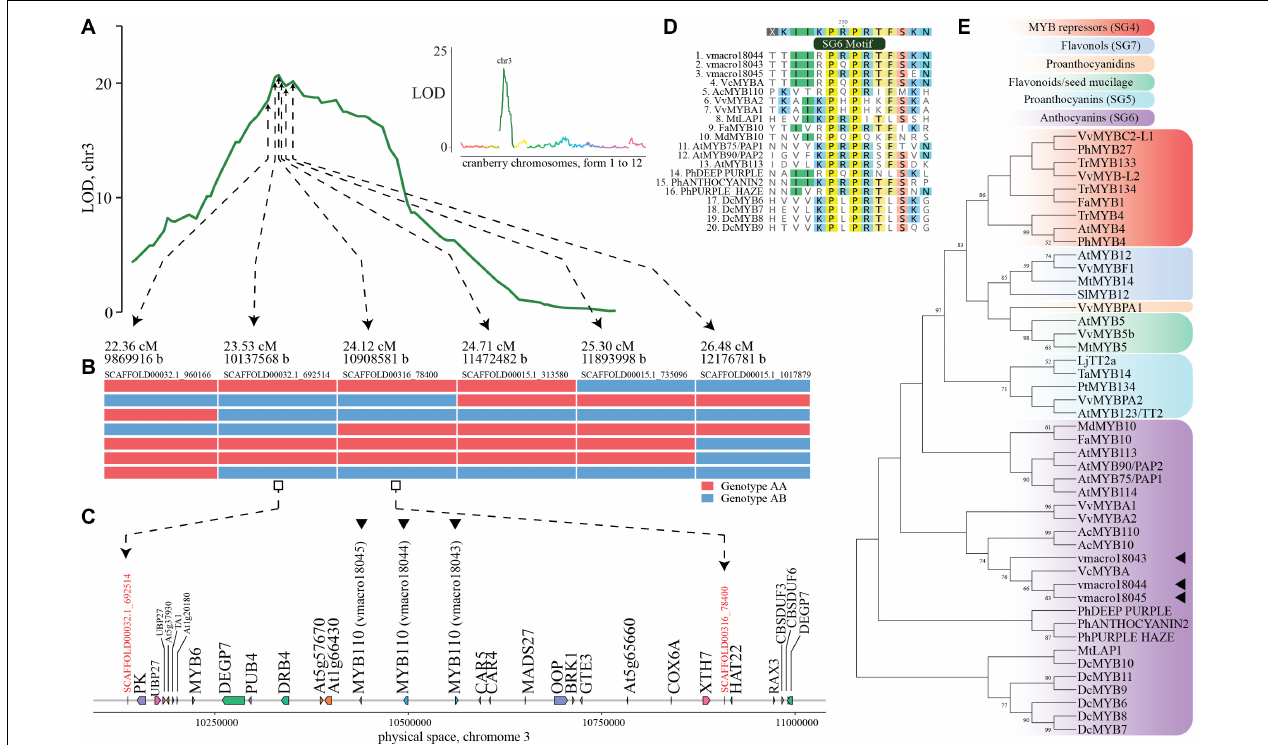
FIGURE 3 | Identification of candidate genes for fruit anthocyanin biosynthesis in cranberry ( Vaccinium macrocarpon Ait.) (A) LOD score profile for total anthocyanin content in the CNJ02 population; in the small panel, LOD profile is shown for the entire genome, whereas the main panel emphasizes chromosome 3. (B) Recombinant haplotypes delimiting the genome region of maximum LOD score (within the 1.5-LOD interval). (C) Schematic representation of gene content within two contiguous markers at maximum LOD score; anthocyanin related genes (vmacro18043-vmacro18045) are marked with a triangle. (D) Multiple alignment of cranberry candidate genes and R2R3MYB anthocyanin-related transcription factors in other species that present the subgroup 6 (SG6) motif. (E) Maximum likelihood phylogenetic tree of cranberry candidate genes and characterized flavonoid-related R2R3MYB sequences from other species. Node support > 50% from 1,000 bootstrap replicates is